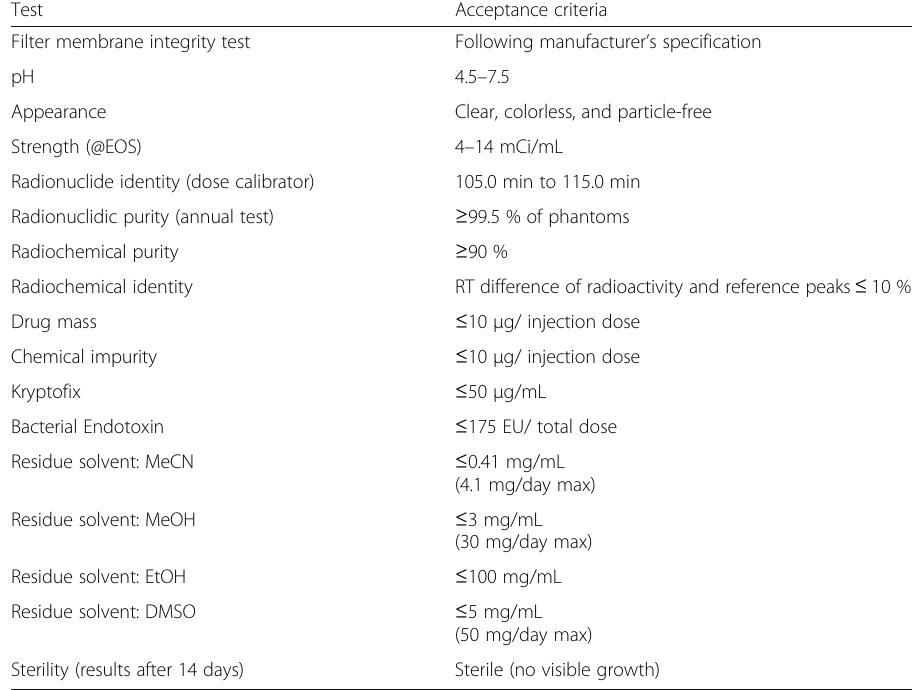
Table 2 Specifications of ISO-1 for clinical